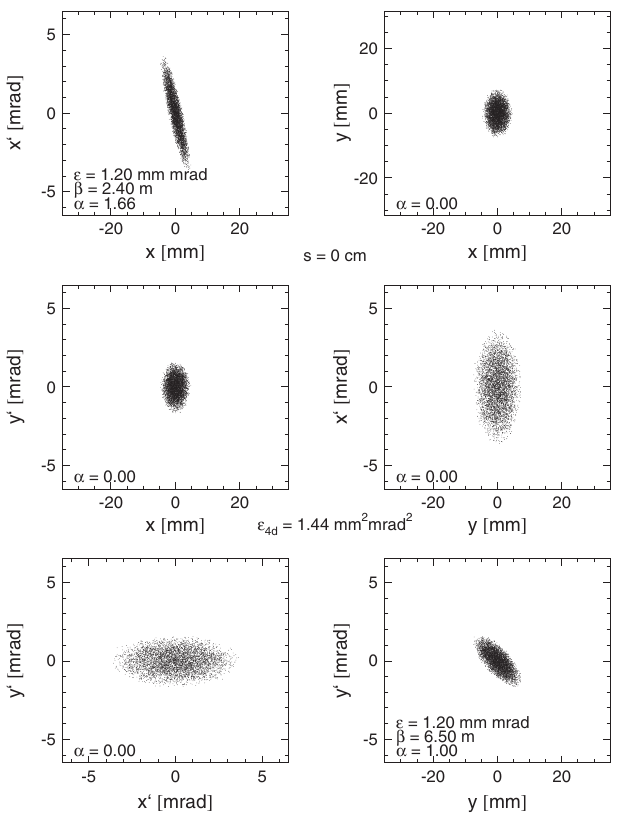
FIG. 10. Two-dimensional projections of the transverse phase space distribution at the entrance to the proposed emittance transfer section along the UNILAC. Horizontal and vertical rms Twiss parameters are indicated as well as the four interplane correlation